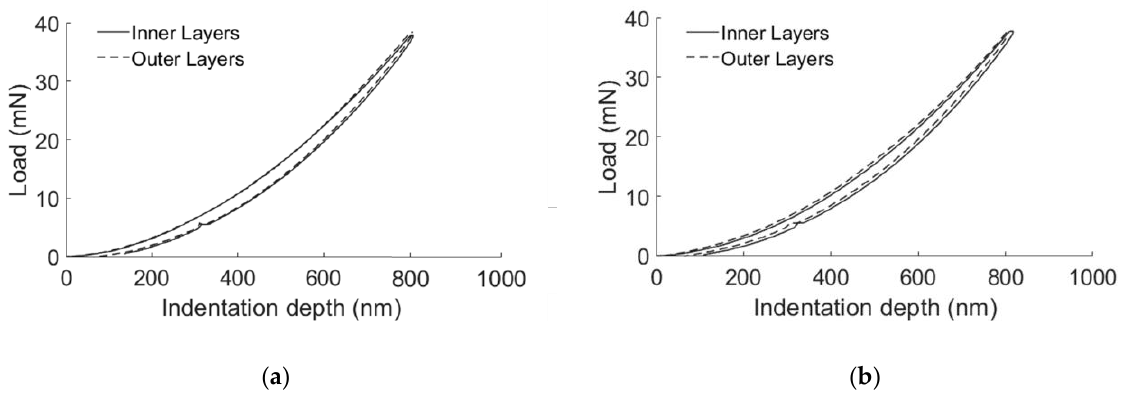
Figure 7. Explanatory curves of nanoindentation tests performed on: ( a ) specimens obtained with the historical deposition process; ( b ) specimens obtained with the modified deposition